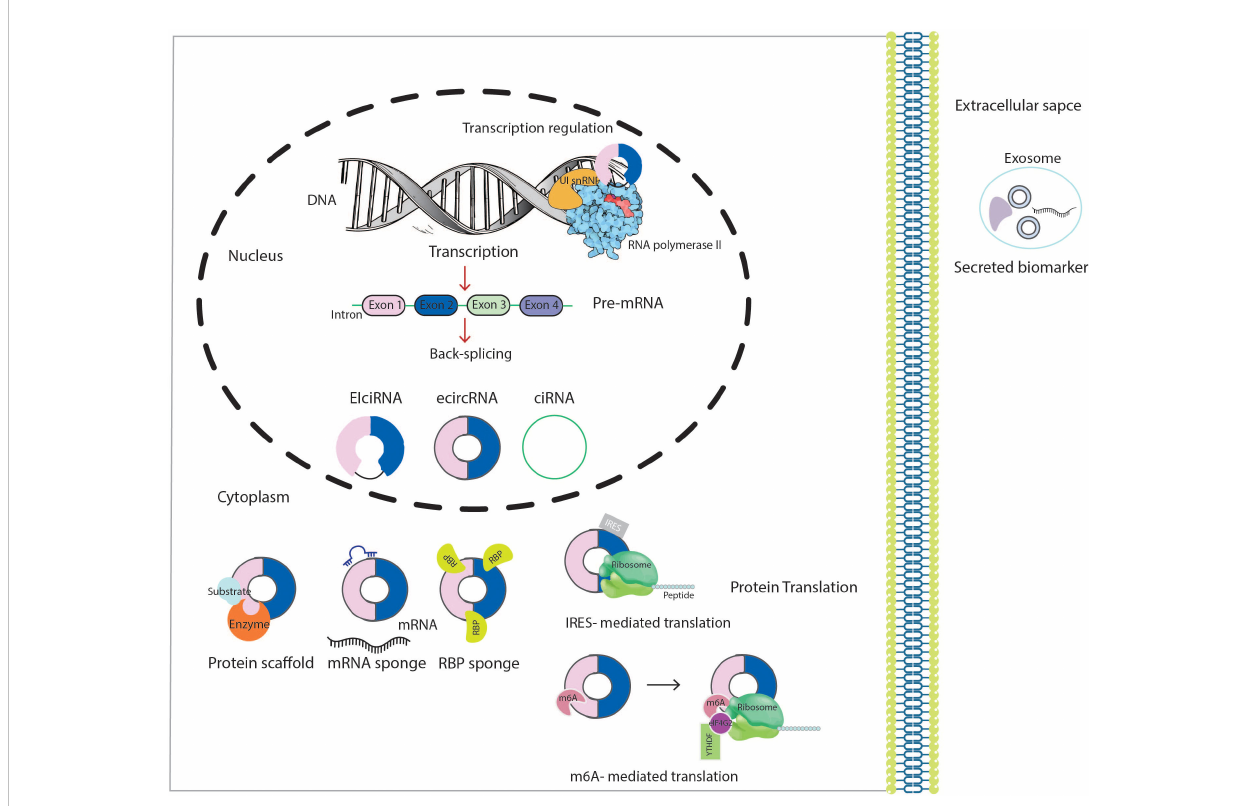
FIGURE 1 Schematic presentation of the biogenesis and biological functions of circRNAs. CircRNA, circular RNA; U1 snRNP, U1 small nuclear ribonucleoprotein; RBP, RNA-binding protein; IRES, internal ribosome entry sites; m6A, methyl adenosine; eIF4G2, eukaryotic translation initiation factor 4 gamma